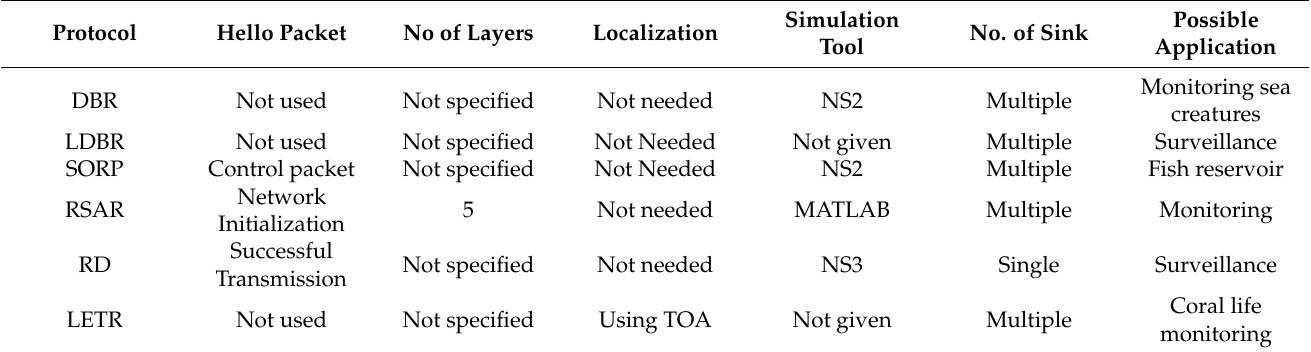
Table 11. Comparison of depth-based routing